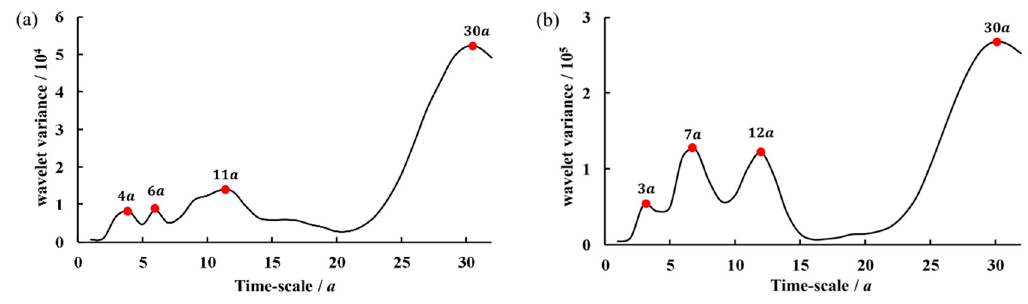
Figure 7. Wavelet variance diagram of runoff and sediment anomaly series. ( a ) Runoff wavelet variance; ( b ) Sediment wavelet variance.